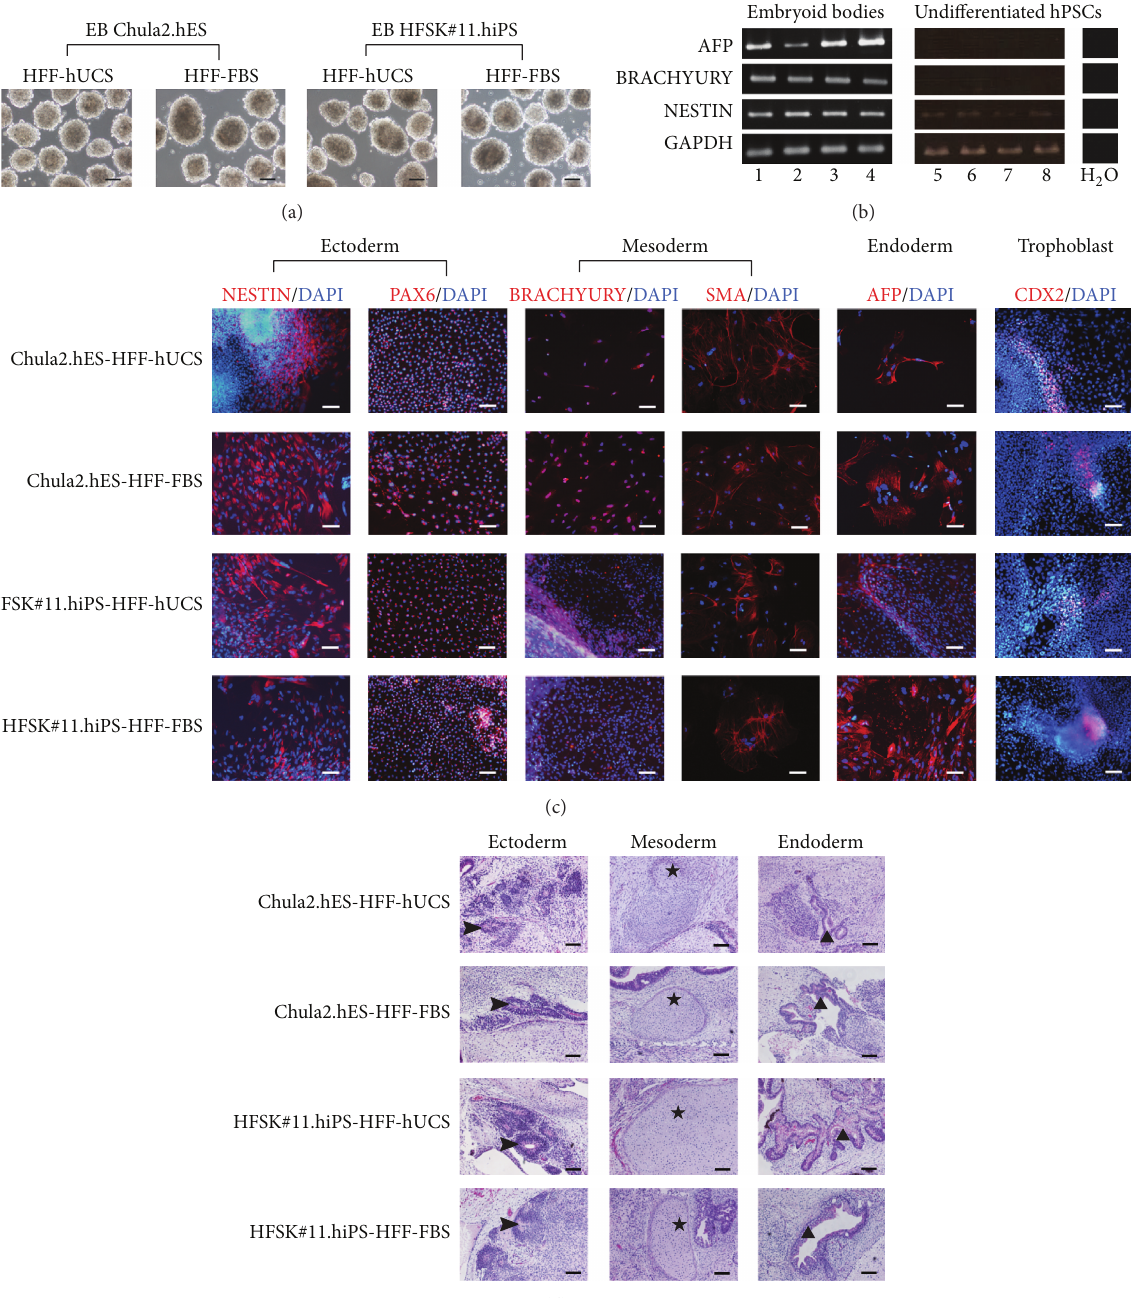
Figure 5: In vitro and in vivo differentiation of human pluripotent stem cell lines cocultured with inactivated HFF-hUCS. The differentiation capacities of hPSC lines cocultured with inactivated HFF-hUCS and inactivated HFF-FBS were determined through the formation of embryoid bodies (EBs) and teratoma formation. hPSC lines cocultured with inactivated HFF-hUCS formed EBs in suspension culture similar to hPSC lines cocultured with inactivated HFF-FBS (a). After the EBs were plated into culture dishes and continuously cultured for 21 days, the EBs differentiated to embryonic germ layers, including the ectoderm (NESTIN, PAX6), mesoderm (BRACHYURY, SMA), endoderm (AFP), and the trophoblast markers (CDX2) were detected through immunostaining (b) and RT-PCR (c). hPSCs lines cocultured with inactivated HFF-hUCS formed teratoma tissue and differentiated into ectoderm (neural rosette-like structure; arrowhead), mesoderm (cartilage; star), and endoderm (gut-like structure; triangle) similar to those cocultured with inactivated HFF-FBS (d). AFP = alpha-fetoprotein, smooth muscle actin (SMA), HFF = human foreskin fibroblasts, FBS = fetal bovine serum, hUCS = human cord blood-derived serum, hPSCs = human pluripotent stem cells, DAPI = 4 󸀠 ,6-diamidino-2-phenylindole, and RT-PCR = reverse transcription polymerase chain reaction. Lane 1 = EB Chula2.hES-HFF-hUCS, Lane 2 = EB Chula2.hES-HFF-FBS, Lane 3 = EB HFSK#11.hiPS-HFF-hUCS, Lane 4 = EB HFSK#11.hiPS- HFF-FBS, Lane 5 = undifferentiated Chula2.hES-HFF-hUCS, Lane 6 = undifferentiated Chula2.hES-HFF-FBS, Lane 7 = undifferentiated HFSK#11.hiPS-HFF-hUCS, and Lane 8 = undifferentiated HFSK#11.hiPS-HFF-FBS. Scale bars (a) and (d) = 200 𝜇 m and (b) = 40 𝜇